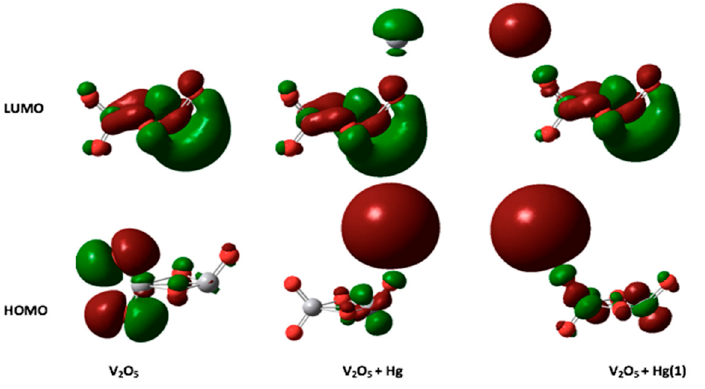
Figure 7. Reaction model of V 2 O 5 and HgCl, HgCl 2 .